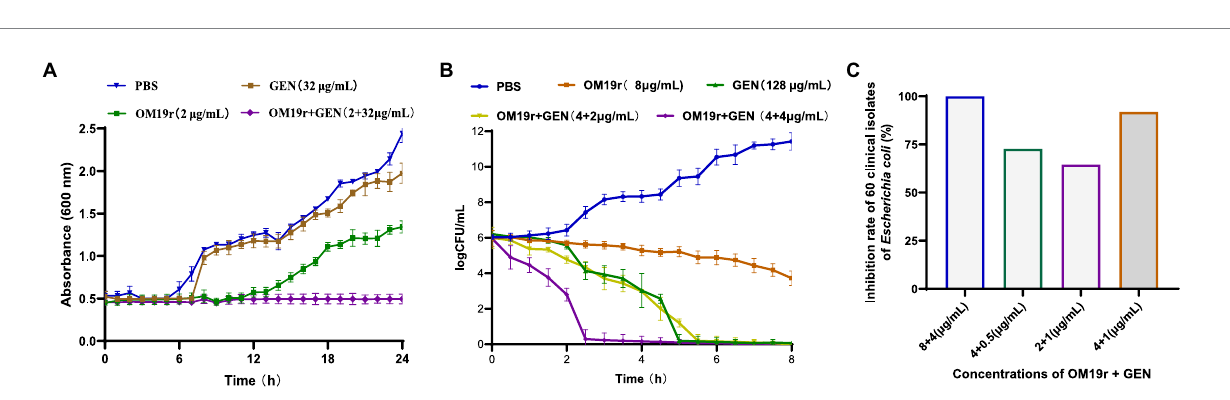
FIGURE 2 Antibacterial effect of OM19r combined with GEN against E. coli . (A) 24 h growth curves of OM19r (2 μ g/ml) combined with GEN (32 μ g/ml) against E. coli B2. (B) 8 h Time-kill curves of OM19r (8 μ g/ml), GEN (128 egg/ml) and OM19r combined with GEN (4 + 2 μ g/ml and 4 + 4 μ g/ml) against E. coli B2. (C) Synergistic antibacterial activity of OM19r combined with GEN against 60 clinically isolated E. coli . Graphs show means from at least three biological replicates, and error bars indicate standard